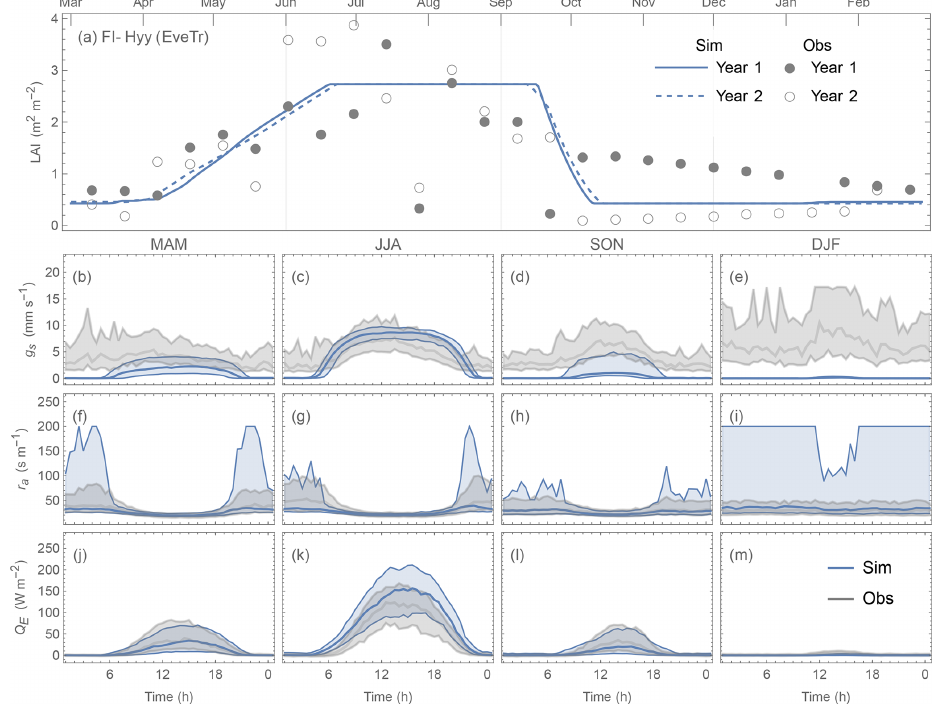
Figure 19. FI-Hyy (EveTr, PS = 0.92) performance: (a) annual LAI, (b–e) g s (in seasonal ensemble of diurnal cycles: median values in bold lines, while interquartile ranges in shadings), (f–i) r a and (j–m) Q E . Note the same colouring of simulations for sites with best and poorest model performance and 6-month offset in annual cycles are applied for consistency with Figs. 16 and